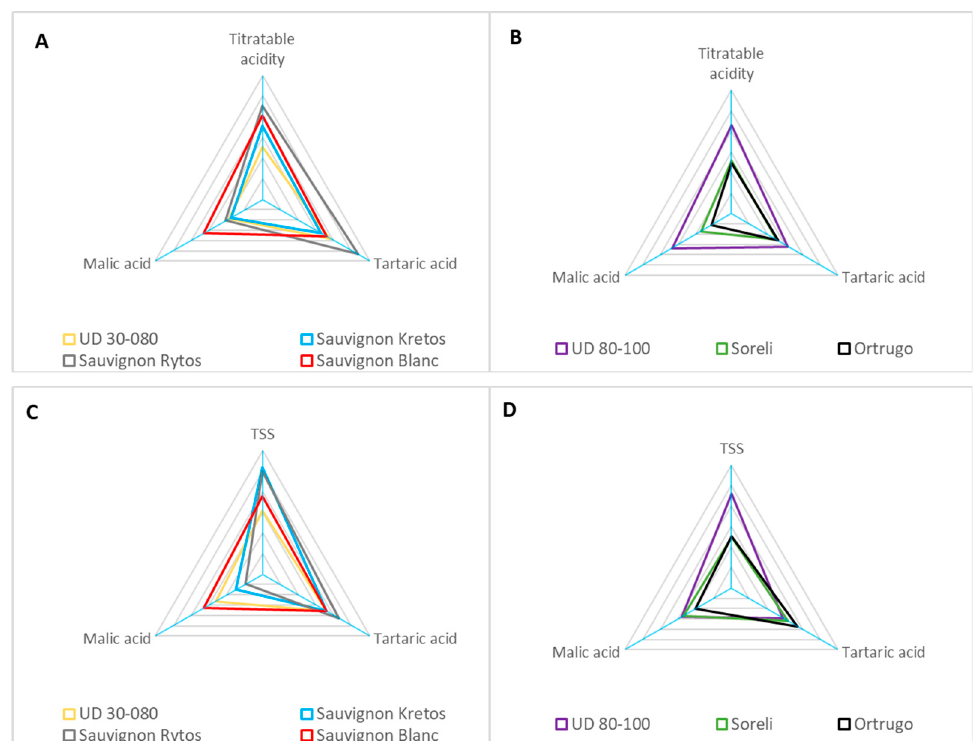
Figure 6. Balance among titratable acidity and organic acids in grapes of 5 pathogens-resistant varieties (white symbols) and 2 reference V. vinifera cultivars (black symbols), at the total soluble solids threshold of about 20 °Brix (panels A , B ) and balance among total soluble solids and organic acids in grapes of the same varieties, at the titratable acidity threshold of about 7 g/L (panels C , D ). Scaling for titratable acidity and tartaric acid is 0–12 g/L, for malic acid is 0–6 g/L, and for total soluble solids is 12–24 °Brix. Data pooled over two seasons.